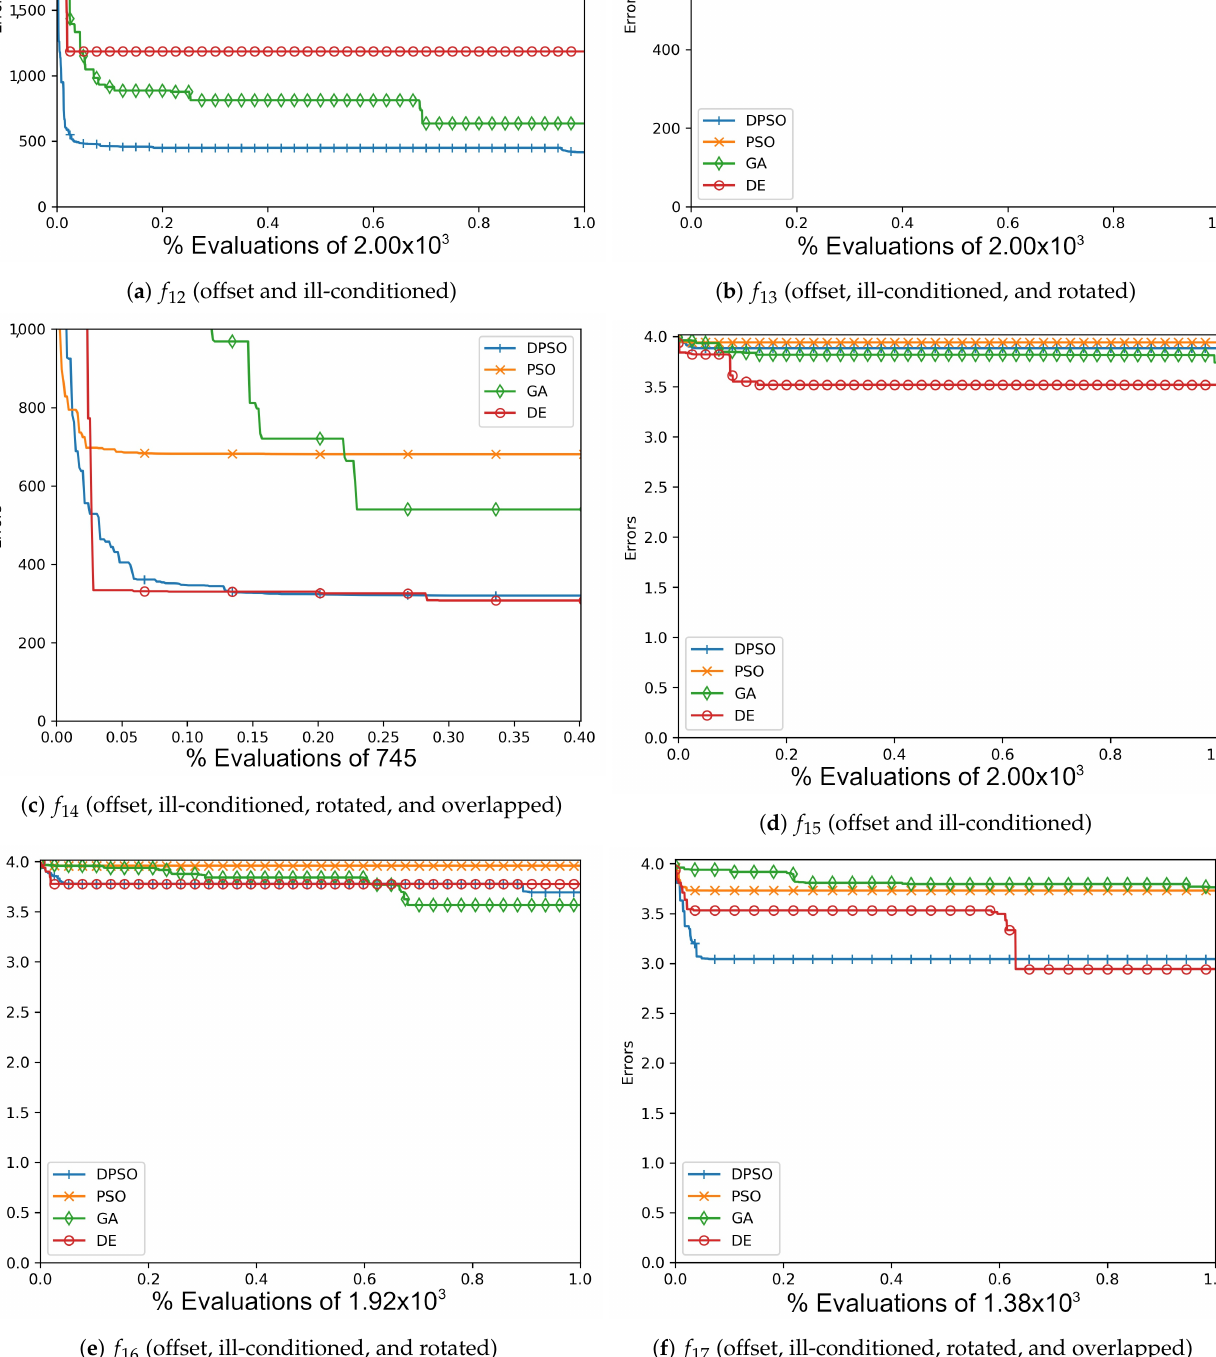
Figure A9. The average Rastrigin ( f 12 , f 13 , f 14 ) and Drop-Wave ( f 15 , f 16 , f 17 ) global best results over time for 21